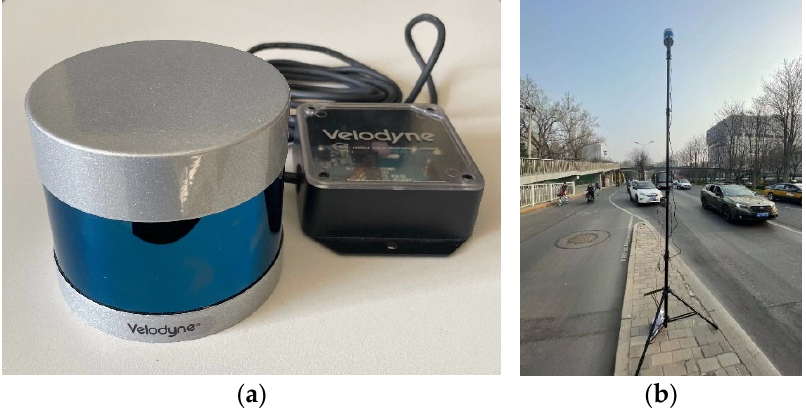
Figure 10. Roadside LiDAR used in the experiment. ( a ) Velodyne 32-line LiDAR. ( b ) Portable tripod with LiDAR mounted on the roadside.